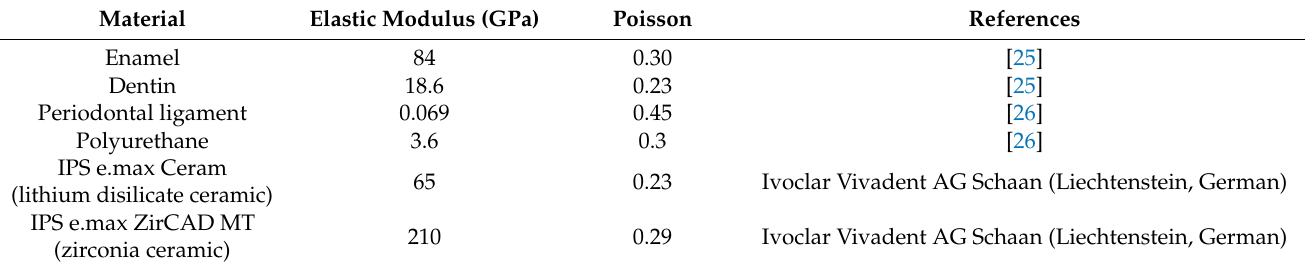
Table 1. Elastic modulus and Poisson ratio of the restorative system